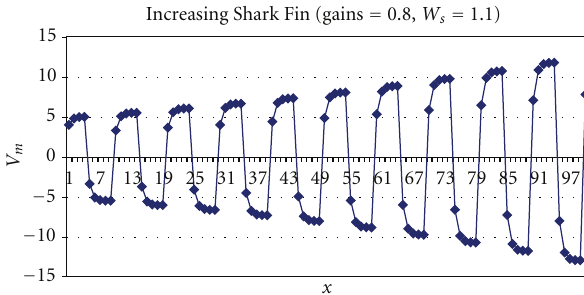
closer to V max at this point than it is to V min , and this is what lets the system come down smoothly from its peak